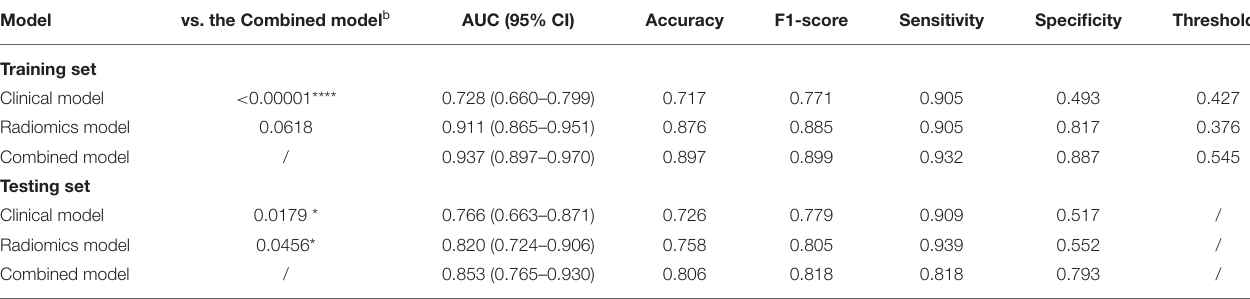
TABLE 3 | Comparisons of predictive models on the training and testing set.